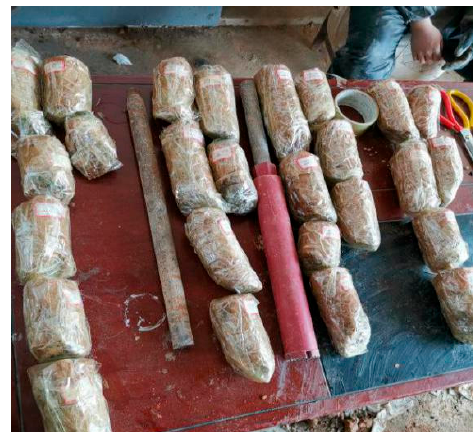
Figure 16. Indoor geotechnical test samples.